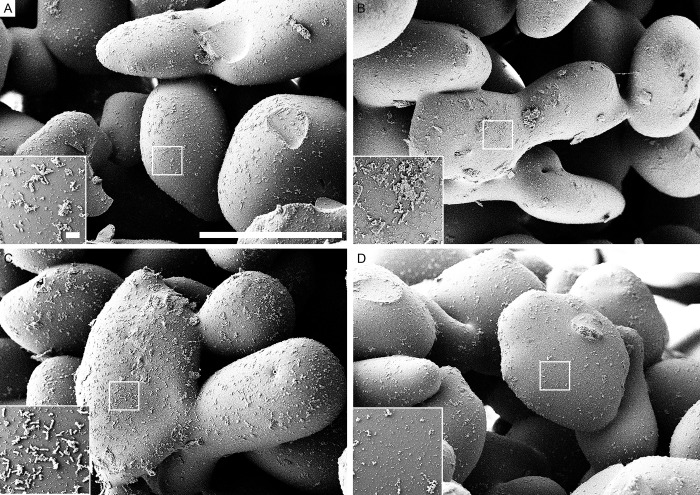
Scanning electron microscopy (SEM) of E. coli biofilm.(A) beads after 0.9% NaCl treatment (control). (B) beads after EDTA treatment. (C) beads after DTT treatment. (D) beads after sonication treatment. Scale bars: 200 μm (inserts in the images represent 5 μm).